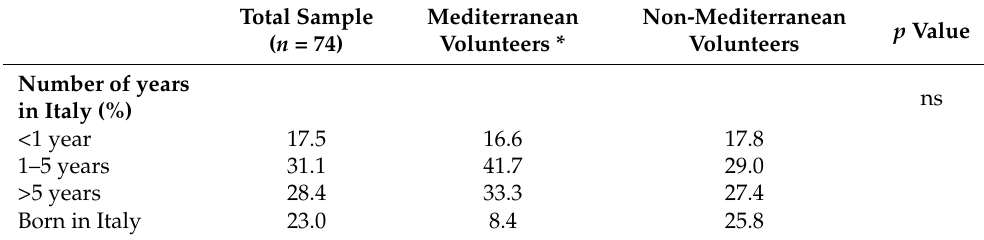
Table 3. Number of years in Italy by geographical area of origin.